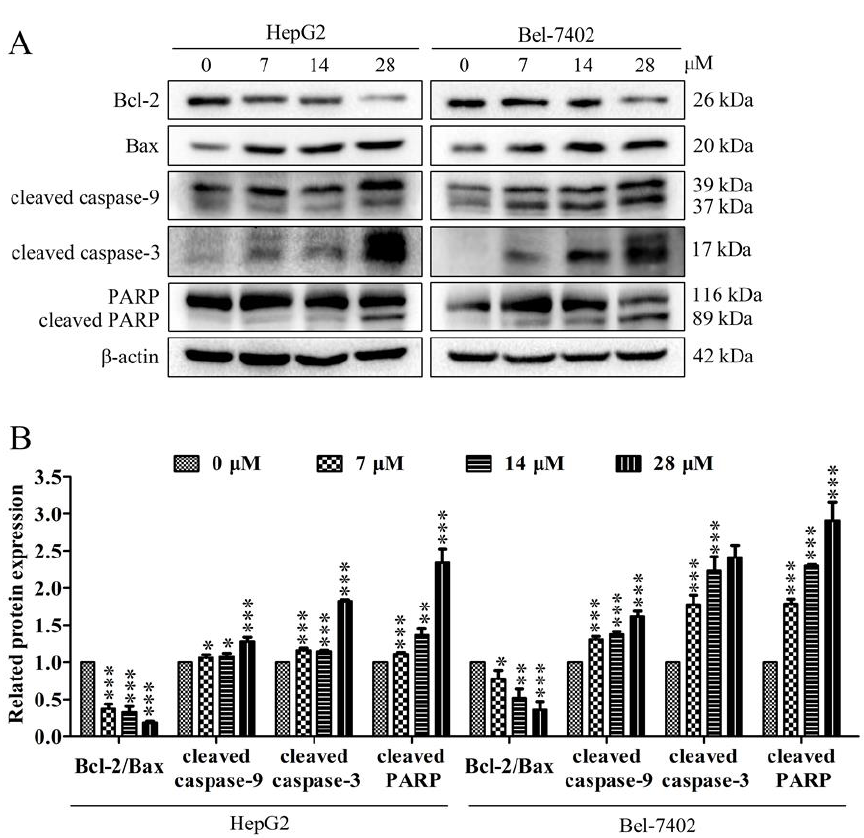
Figure 4. Effects of Davidone C on the apoptosis regulatory proteins of liver cancer cells. ( A , B ) The related expressions of Bcl-2/Bax, cleaved caspase-9, cleaved caspase-3 and cleaved PARP in HepG2 and Bel-7402cells were detected by Western blotting. β -actin was used as a control (* p < 0.05, **p < 0.01 or ***p < 0.001). 2.5. Effect of Davidone C on endoplasmic reticulum stress (ERS) pathway in HepG2 and Bel-